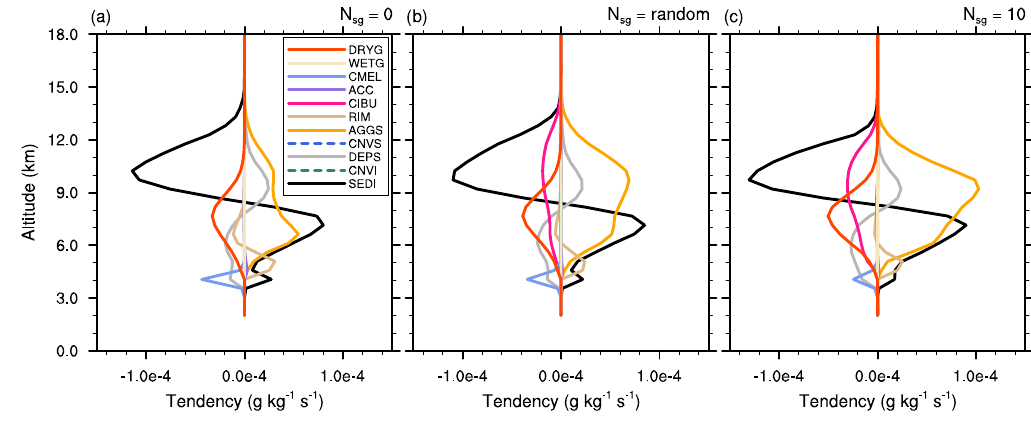
Figure 10. As in Fig. 9 but for snow aggregates.